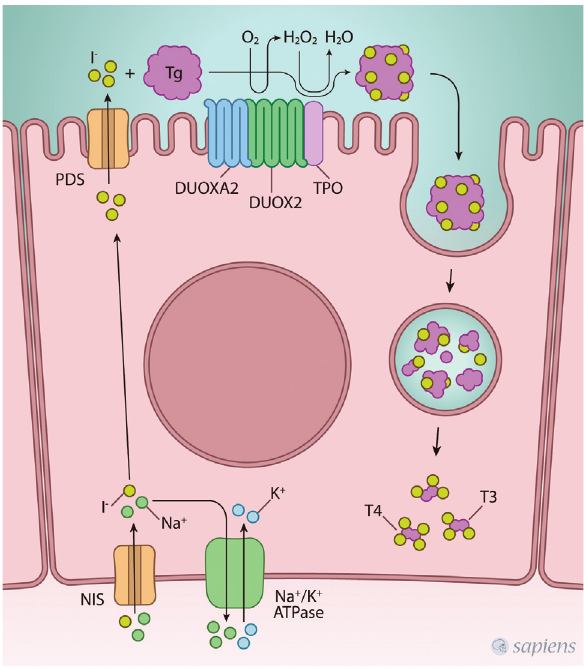
Figure 2 - Schematic representation of thyroid hormones biosynthesis at the apical membrane of thyrocytes. The inorganic iodide from the diet is actively transported by the sodium iodide symporter (NIS) through the basolateral plasma membrane of follicular cells. After that, iodide is translocated from the cytoplasm across the apical plasma membrane into the follicular lumen through pendrin (PDS). At the interface of the apical thyroidcellplasmamembraneandthecolloid,thyroperoxidase(TPO)cat- alyzes the three steps of HT biosynthesis, and its activity depends on the presence of hydrogen peroxide (H 2 O 2 ), which is an essential cofactor for its catalytic activity, being generated by the enzyme dual oxidase 2 (DUOX2), which is also located at the apical membrane of thyrocytes. DUOXA2 is crucial to ER-to-Golgi transition and targeting of DUOXs to the plasma membrane.